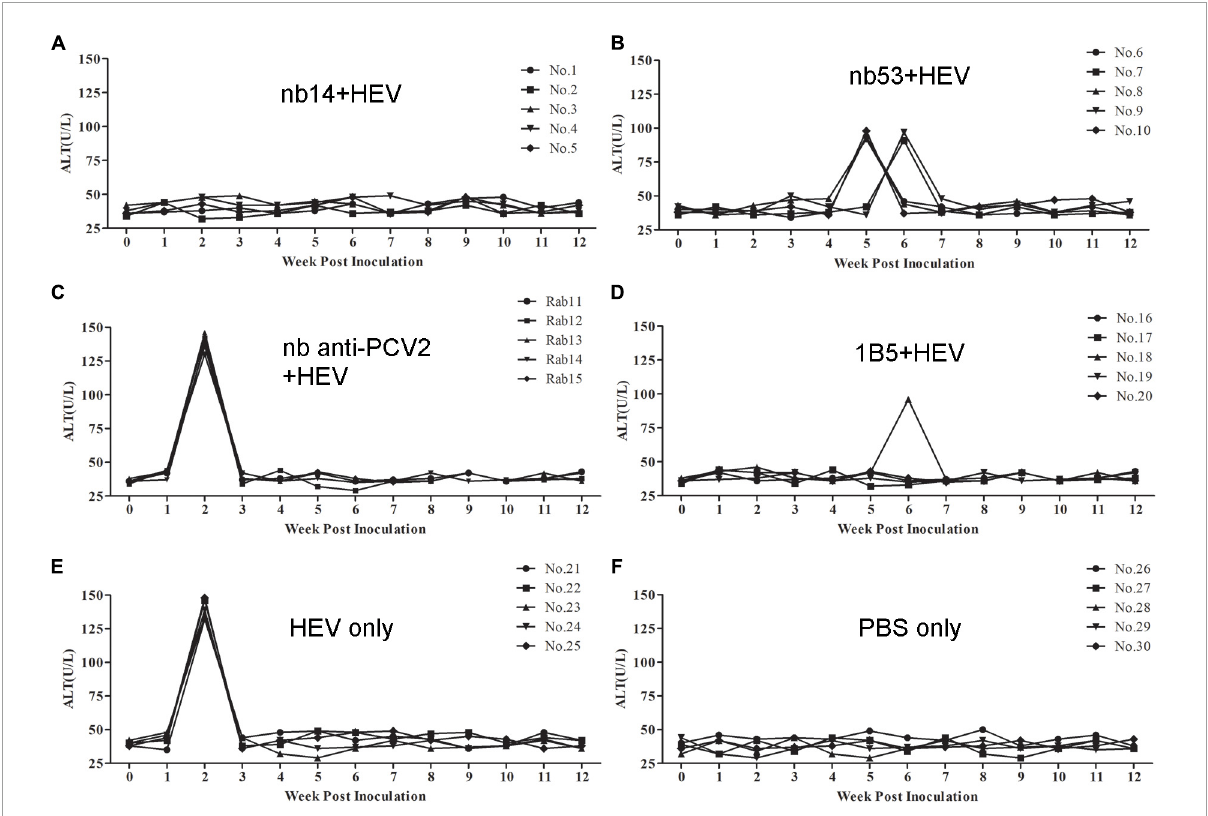
FIGURE5 The alanine aminotransferase (ALT) levels of liver enzymes in the serum of different groups of rabbits. (A–D) Rabbits inoculated with swine HEV mixed with nb14, nb53, nb anti-PCV2, or MAb 1B5. (E,F) Rabbits inoculated with only swine HEV or